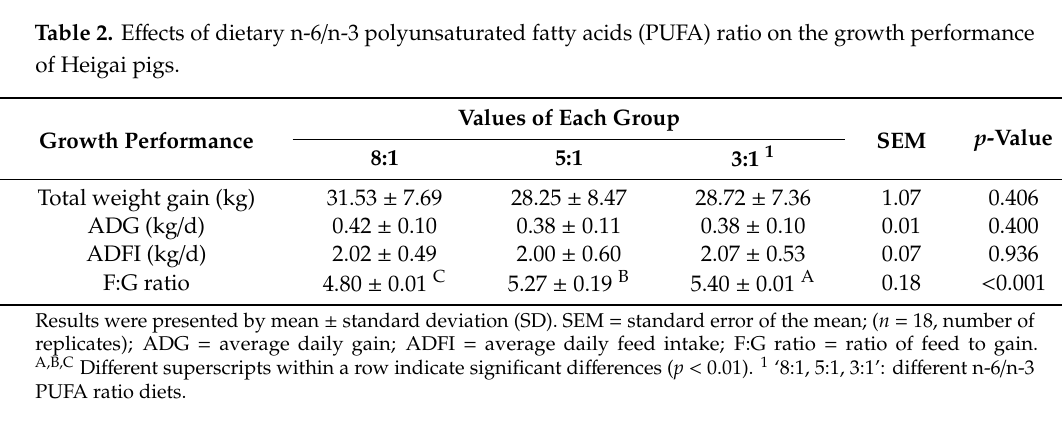
Table 3. E ff ects of dietary n-6 / n-3 PUFA ratio on the carcass traits of Heigai pigs. Carcass Quality Traits